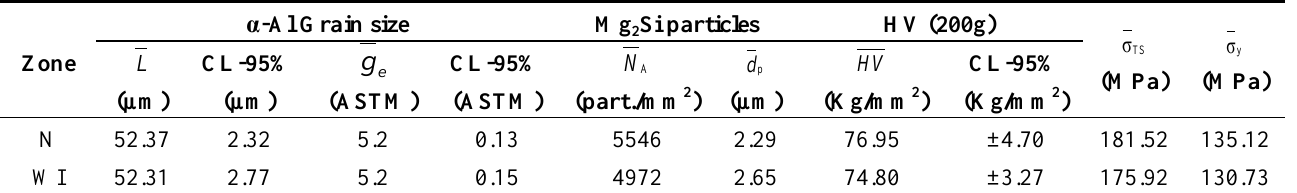
Table 2. Microstructural and mechanical results in the cross section of the extruded billet.